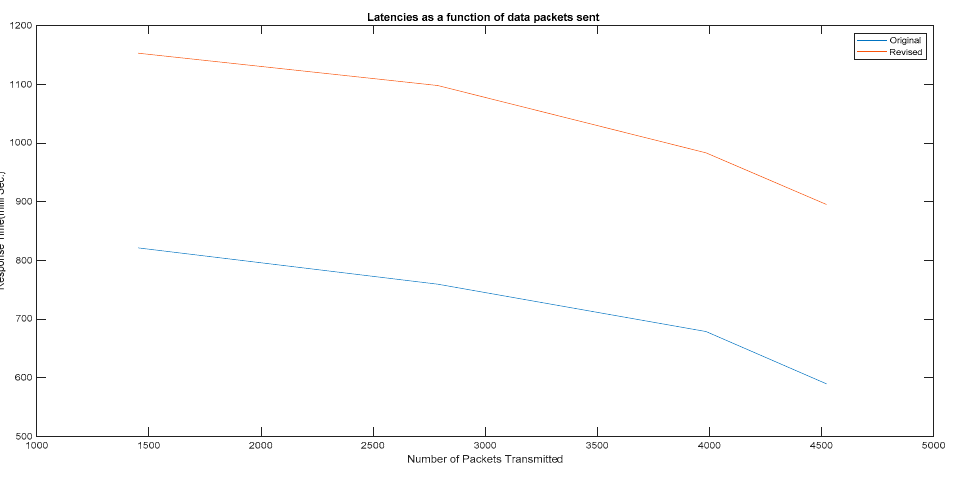
Figure 7. Connectivity paths vs. response comparative study.